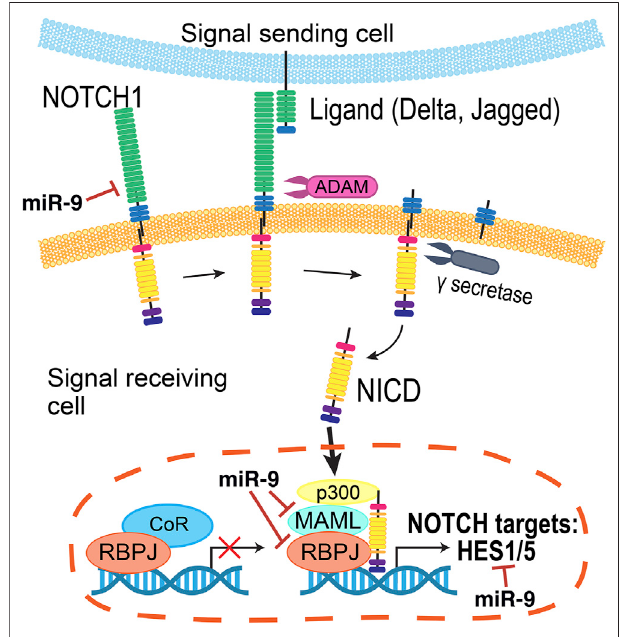
FIGURE 5 | Summary of the Notch pathway. Notch signaling is initiated when a transmembrane Notch receptor (Notch1-4) on one cell is activated by a neighboring cell ’ s ligand (Delta, Jagged/Serrate), prompting proteolytic cleavage events by ADAM and γ -secretase to release the Notch receptor ’ s intracellular domain (NICD). Inside the cell, NICD translocates into the nucleus to form a transcriptional complex with a number of co-activators to in turn activate the expression ofgenes, including the Hes and Hey families. The miRNA miR-9 regulates several members of this